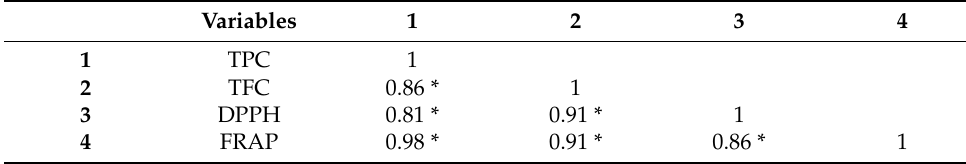
Table 7. Pearson correlation of polyphenolic compounds and antioxidant activities of different samples of Labisia pumila var. alata